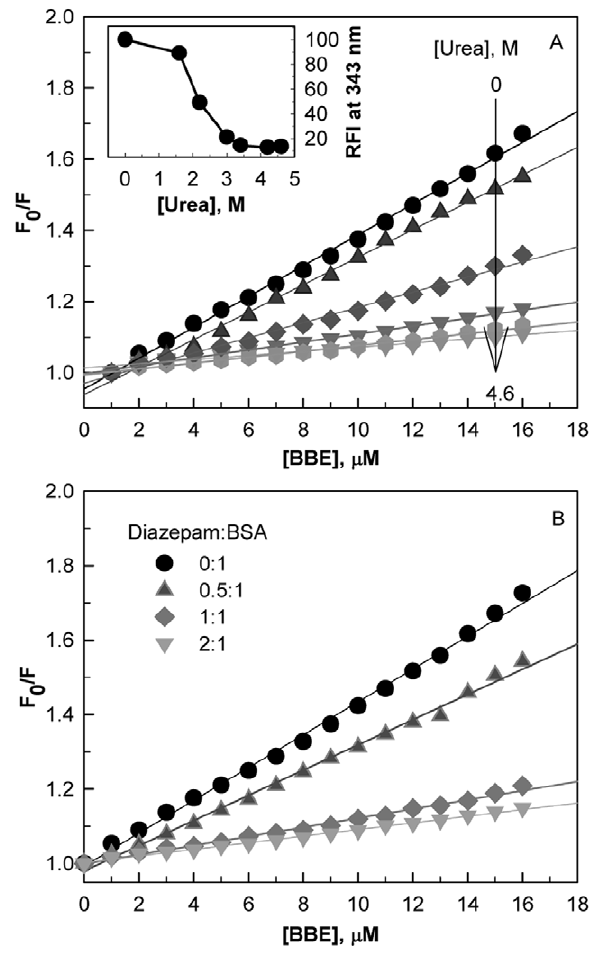
Figure 5. The location of the BBE binding site using unfolding mechanism of BSA and site specific marker. Stern-Volmer plots of BBE-induced fluorescence quenching of BSA with increasing concen- tration of urea (A). The inset shows the effect of increasing concentrations of urea on the BBE-induced fluorescence quenching of the protein at a fixed BBE/BSA molar ratio of 2:1. Site specific marker displacement experiments.Stern-Volmer plots of BBE-induced fluores- cence quenching of BSA pre-incubated with different concentrations of diazepam, a subdomain IIIA site marker (B).